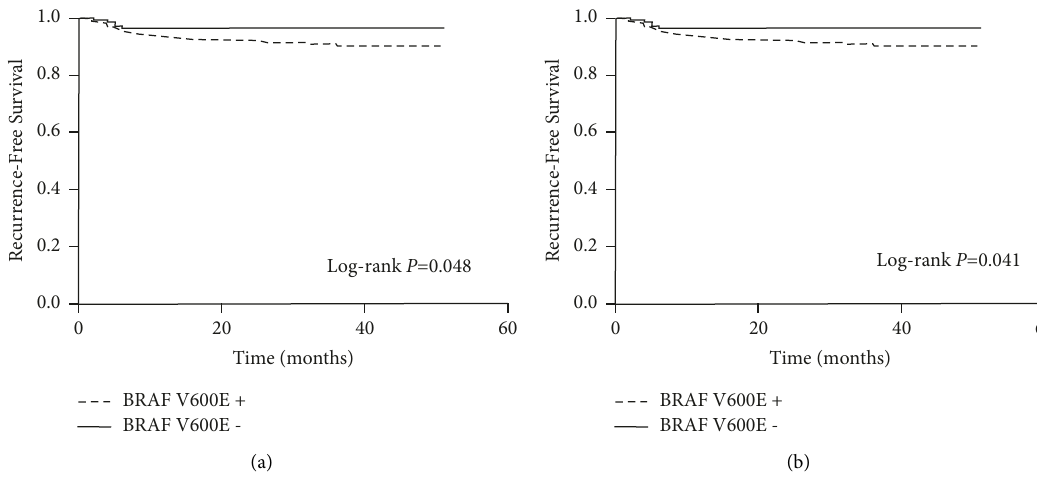
Figure 1: Kaplan–Meier survival analysis of disease recurrence-free survival of patients with PTC (a) and CPTC (b), stratified by BRAF V600E status. Table 2: Recurrence and HRs for BRAF V600E-positive versus negative in PTC and CPTC patients.